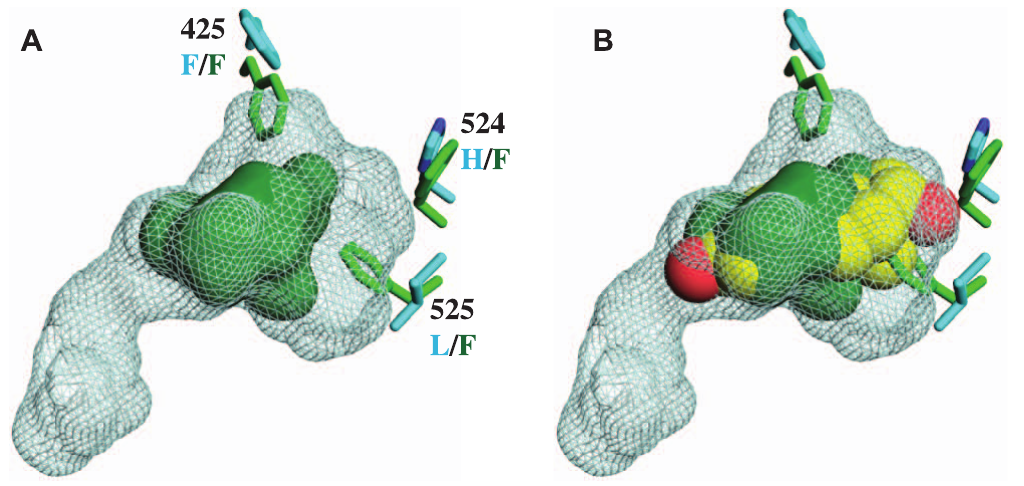
Figure 2. CgER ligand binding pocket is too small to accommodate estradiol. A. The ligand cavity in the human ER a (1GWR, cyan mesh) is much larger than the corresponding volume in CgER (solid green). Side chains of residues that occlude the cavity in CgER are shown as sticks; residue numbers are from human ER a , with states in CgER and human ER a labeled in green and cyan text, respectively. B. The CgER cavity is too small to accommodate estradiol (yellow spheres, positioned as in 1GWR).